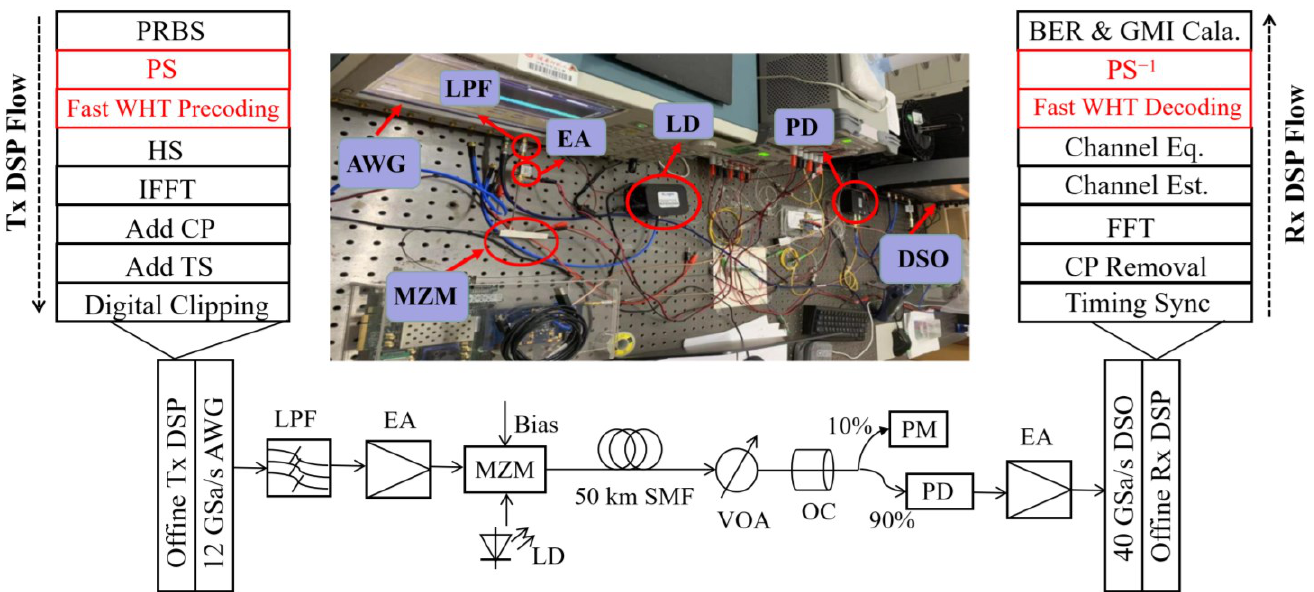
Figure 3. Experimental setup of the PS-DMT system enabled by fast WHT-based PDSP scheme.